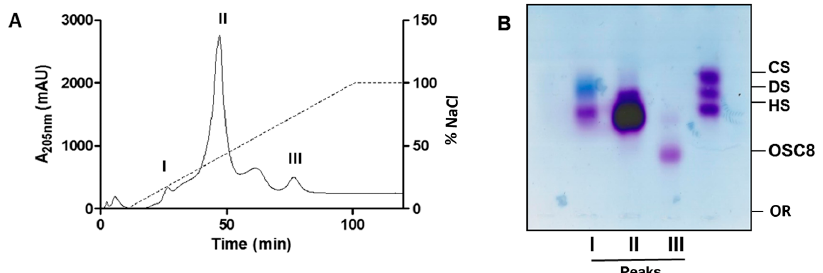
Figure 4. Purification of sulfated contaminants by ion exchange chromatography. ( A ) Elution profile of the crude heparin preparation C8 on Q-Sepharose ion exchange chromatography. I, II and III: the fractions shown in A were combined according to their elution profile and named peaks I to III. ( B ): Agarose gel electrophoresis in PDA bu ff er of Q-Sepharose fractions. Peak III corresponds to the contaminant OSC8, isolated from C8 crude heparin. CS/DS/HS: standard mixture of chondroitin sulfate (CS), dermatan sulfate (DS) and heparan sulfate (HS); Or: Origin.